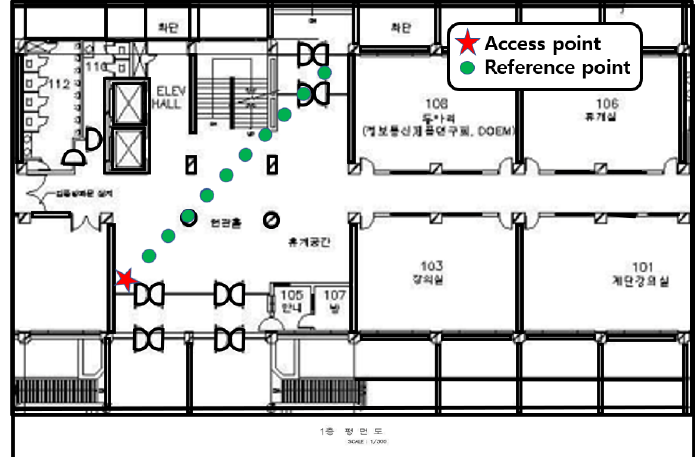
Figure 9. Schematic diagram of indoor experiment environment at the 2rd floor of IT-2